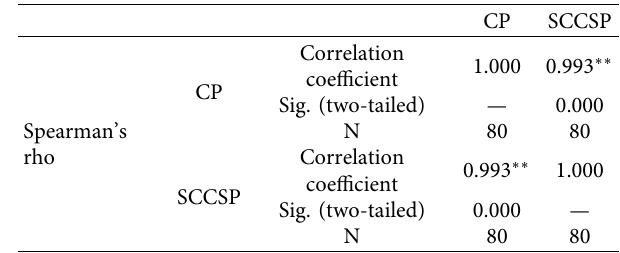
Figure 3: Tree categories of skin-cast contact surface pressure levels in the application. (a) Te frst category is the “normal pressure category” with pressure values of 0–50mmHg and is shown in “green.” (b) Te second category is defned as pressure values of 50–75mmHg, indicating increased pressure and a moderate risk of developing compartment syndrome, and is indicated by “yellow.” (c) Te third category is defned as pressure values > 75mmHg, indicating increased pressure and a high risk of developing compartment syndrome, and is indicated by “red.” Table 1: Mean SCCSP with respect to the mean CP. Table 2: Spearman’s correlation analysis between CP and SCCSP.